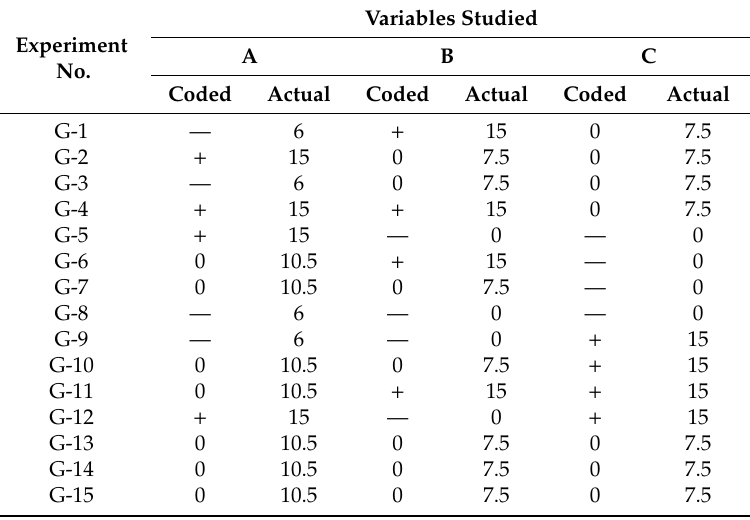
Table 4. Design matrix for Box–Behnken experiments.